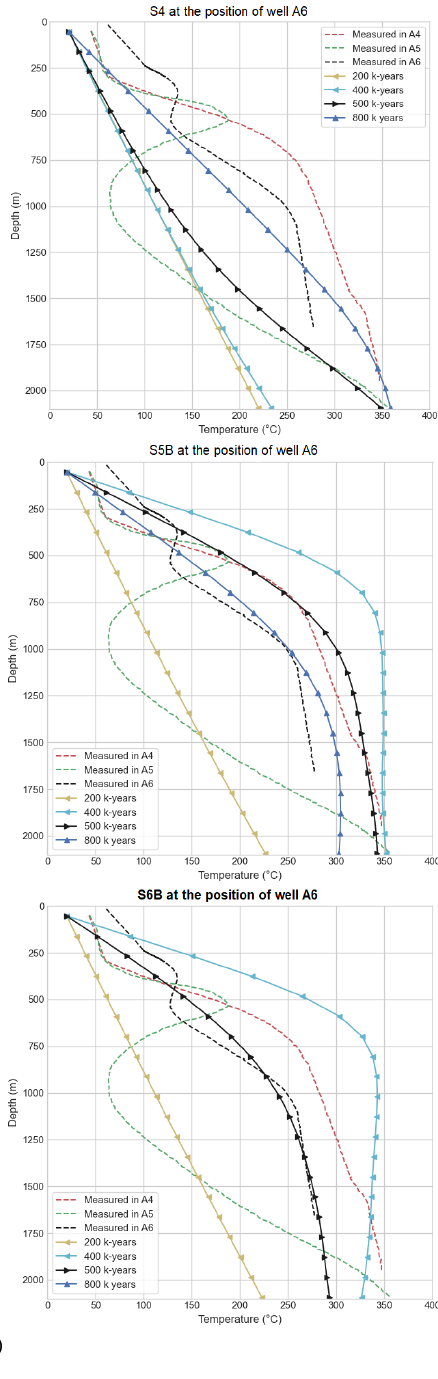
Figure 8. ( a ) Comparison between the observed and simulated temperatures at well A4. The word S represents scenario. ( b ) Comparison between the observed and simulated temperatures at well A6. The word S represents